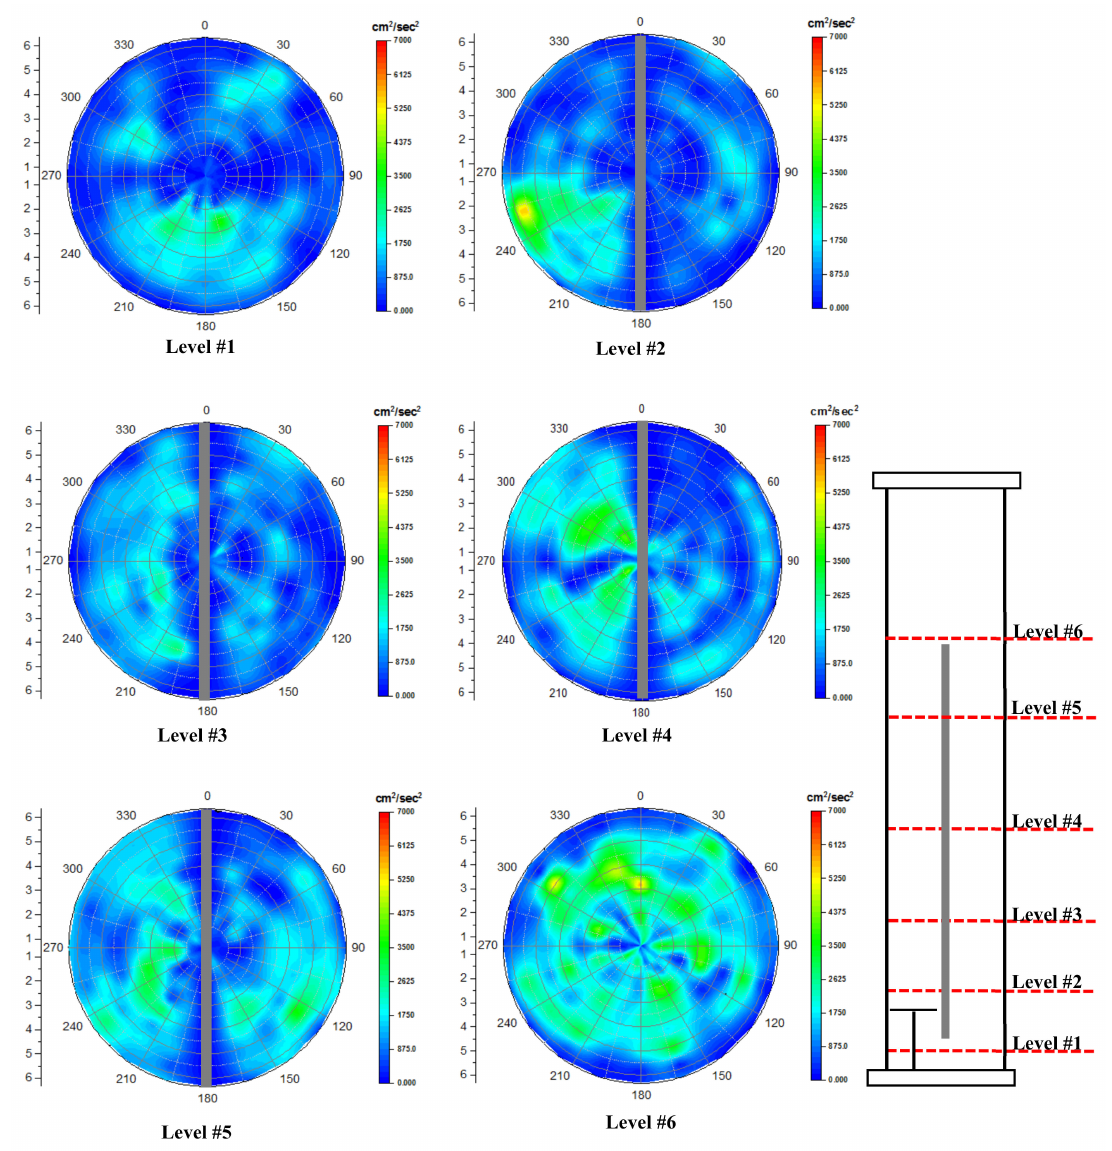
Figure 16. Cross-sectional distributions of shear stress at different heights of split airlift reactor operated under gas velocity of 1